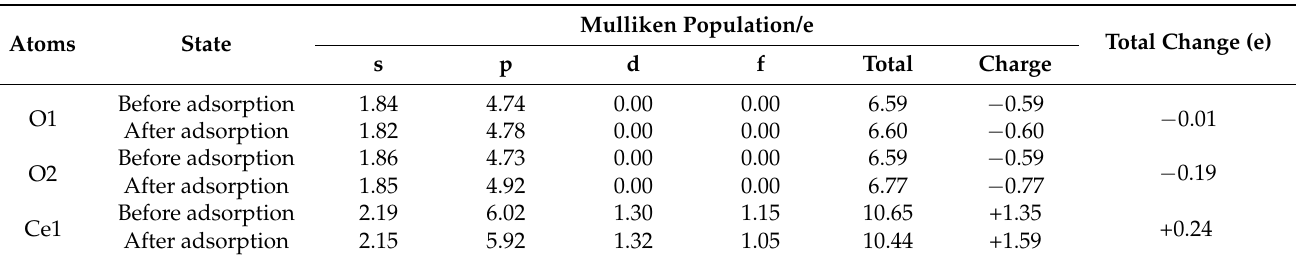
Table 1. Mulliken populations of O and Ce before and after NHA adsorption on the bastnaesite (100) surface.